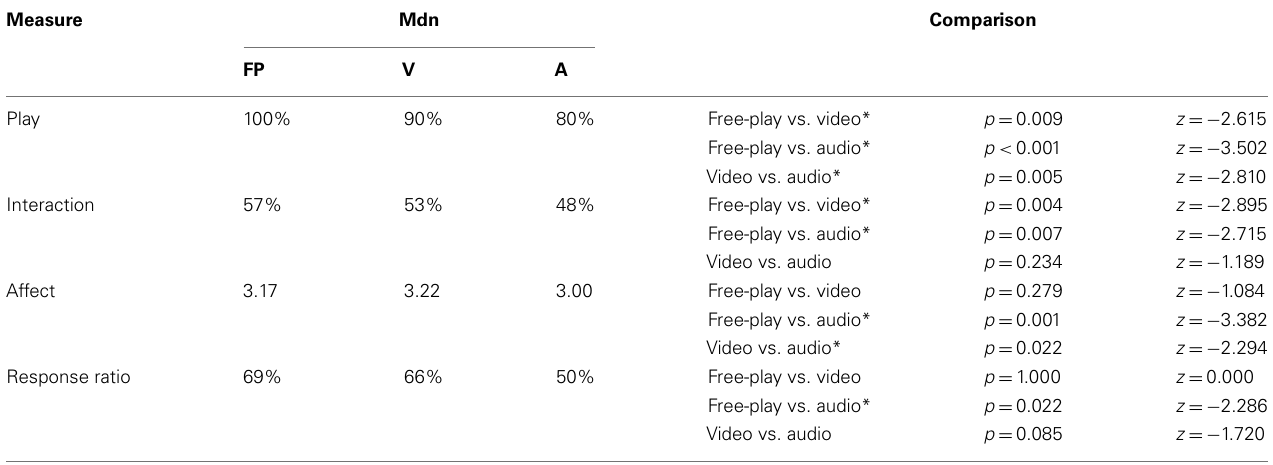
Table 3 | Medians behavioral scores across episodes andWilcoxon signed rank test